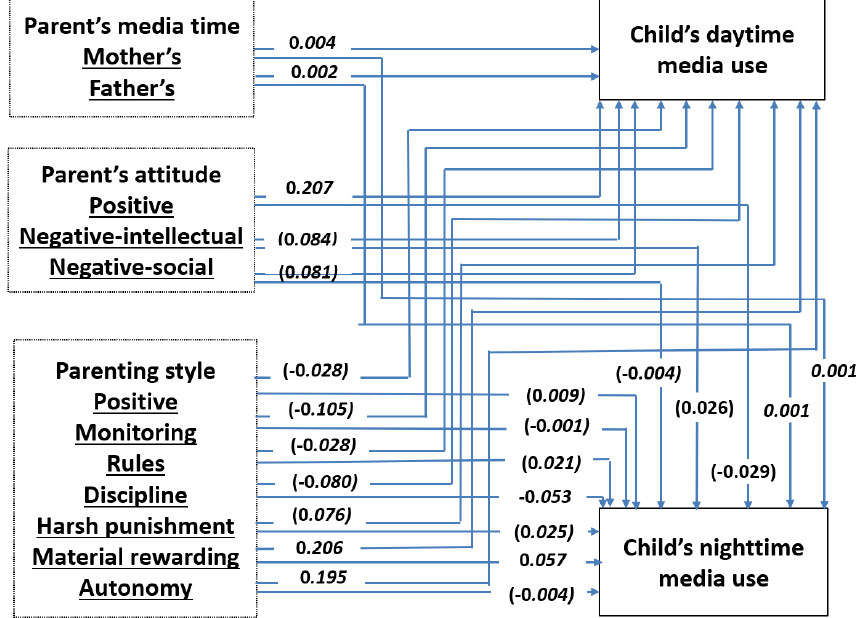
Figure 1. Final model of the relationships among child’s daytime and nighttime media use, parent’s media time, parent’s attitude toward media use, and parenting style. Note that the values are the observed standardized path coefficients. The path coefficients without parentheses are significant at p < 0.05.